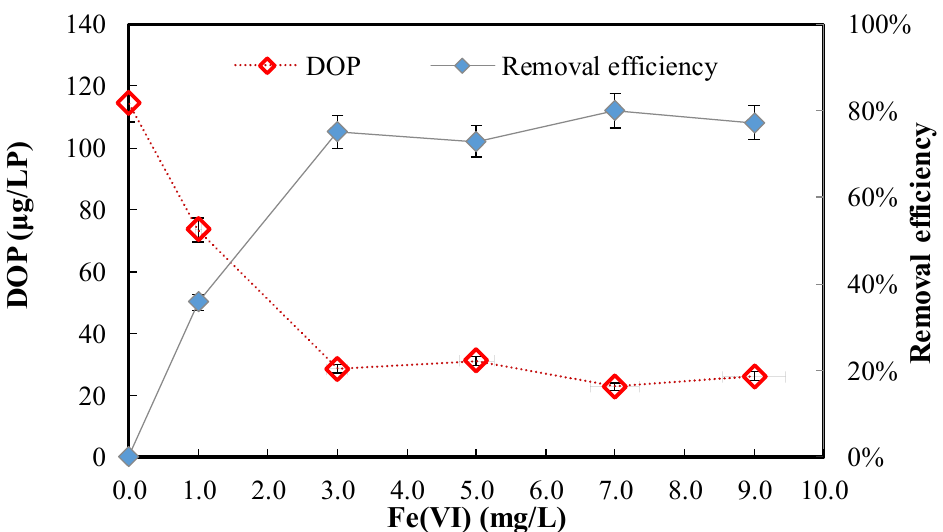
Figure 1. Residual DOP and DOP removal efficiency after ferrate (VI) treatment of secondary efflu- ent at different Fe (VI) doses. (DOP = 114 μ g/L as P; Fe (VI) = 0.0–9.0 mg/L).